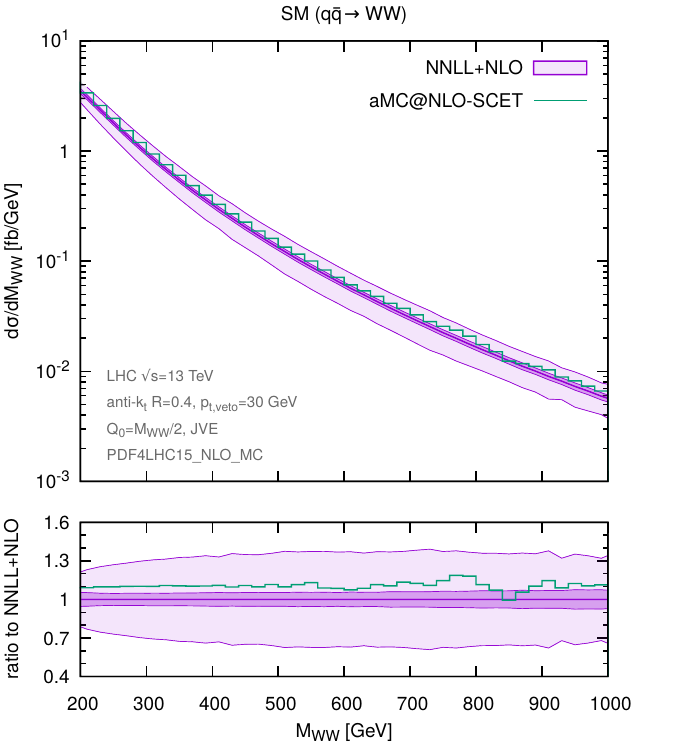
Figure 2 . The differential distribution dσ/dM method, and with the program aMC@NLO-SCET [29]. See the main text for